Question: Give a one-sentence summary of this figure.
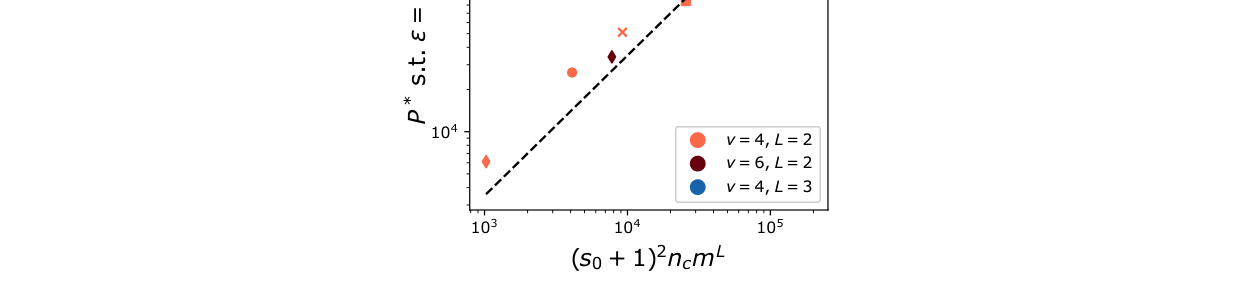
Answer: CNN: Empirical sample complexity P ∗to reach a 10% test error ε versus prediction Eq. 4 for s = 3, for vocabulary size v and different depths L (different colors), maximal m = vs−1 and different s0 (different markers).